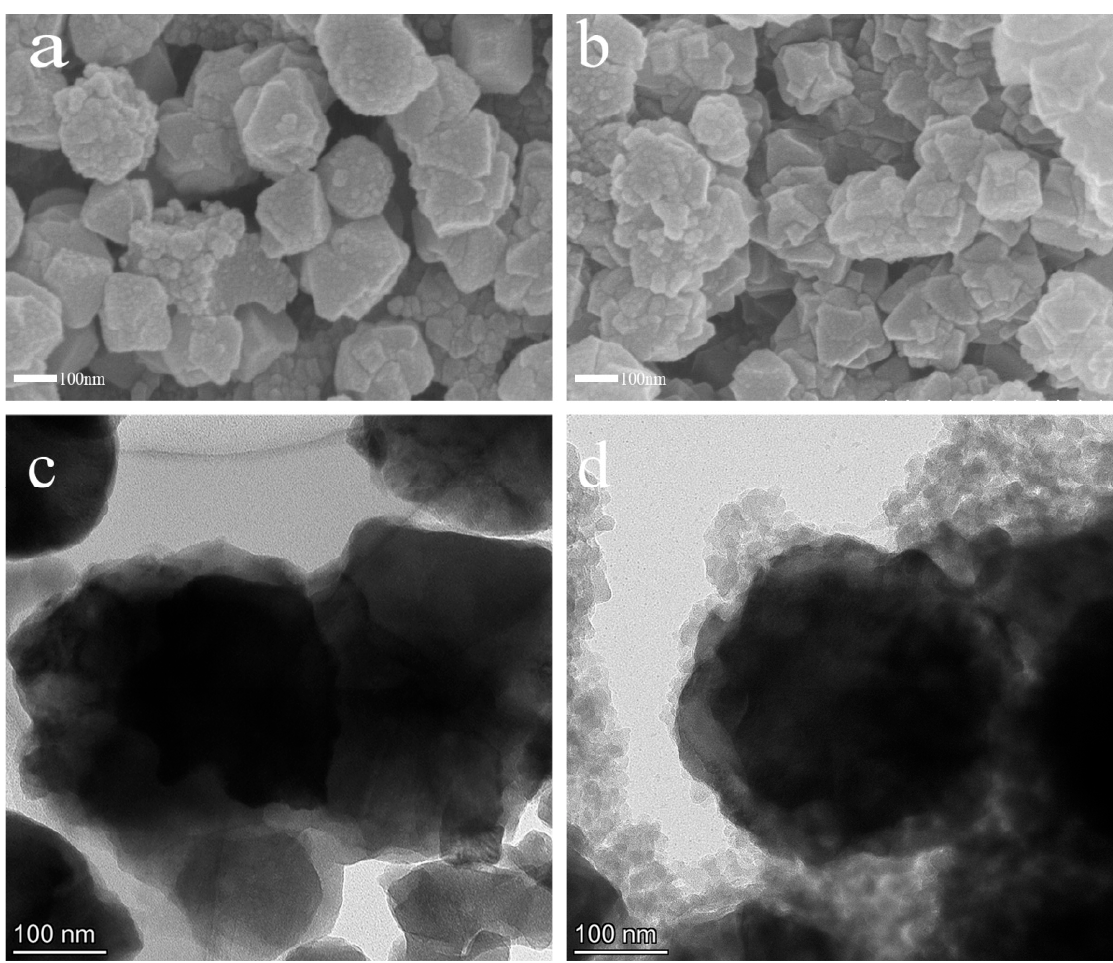
Figure 2. SEM images of Fe 3 O 4 @UiO-66-NH 2 ( a ) and IL-Fe 3 O 4 @UiO-66-NH 2 ( b ); TEM images of Fe 3 O 4 @UiO-66-NH 2 ( c ) and IL-Fe 3 O 4 @UiO-66-NH 2 ( d ).